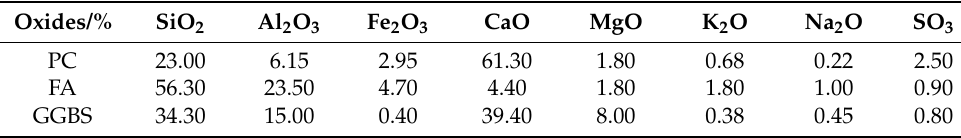
Figure 1. Photo of fly ash (FA), Portland cement (PC) and ground granulated blast furnace slag (GGBS). Table 1. Chemical composition of the PC, FA and GGBS.